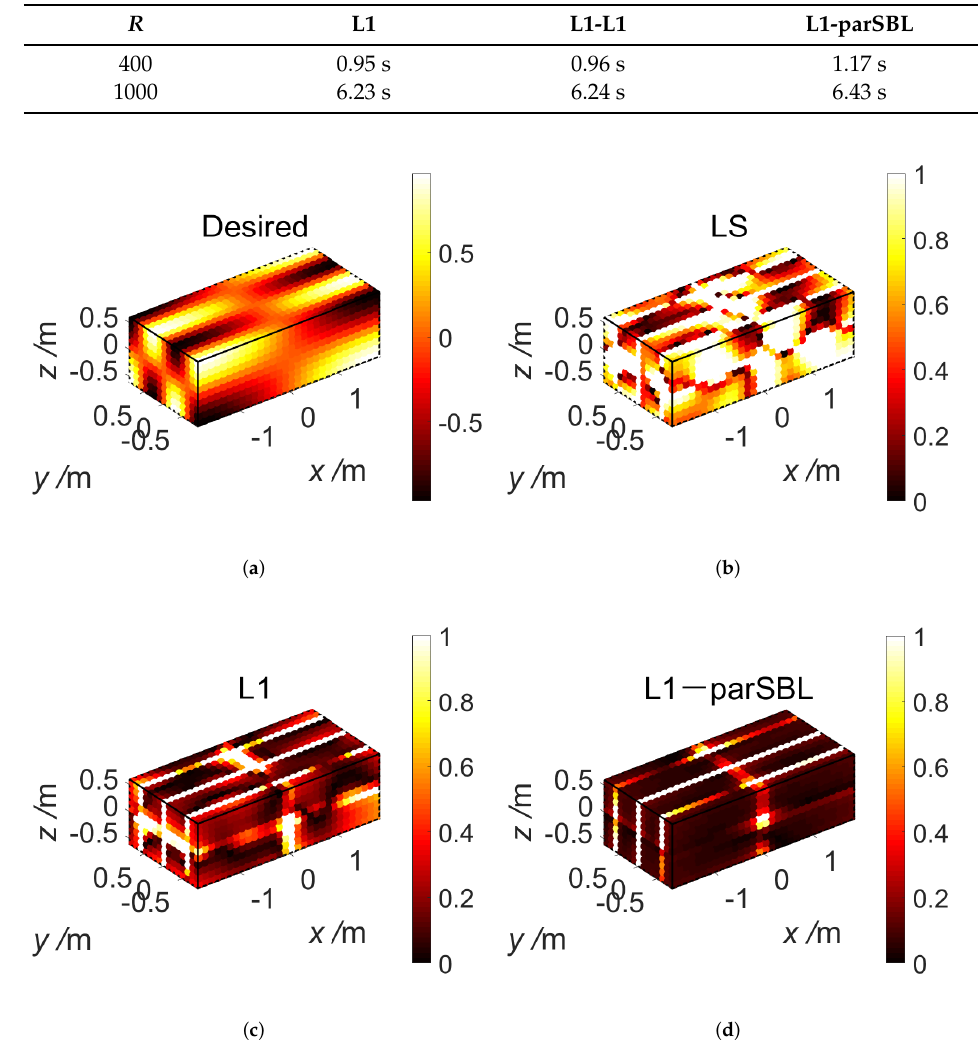
Figure 4. (Color online) Results of the PW approximation for the (1, 3, 1) mode with R = 400. ( a ) Desired mode shape. ( b – d ) Spatial distribution of relative errors of the reconstructed mode when using ( b ) LS, ( c ) L1, and ( d )